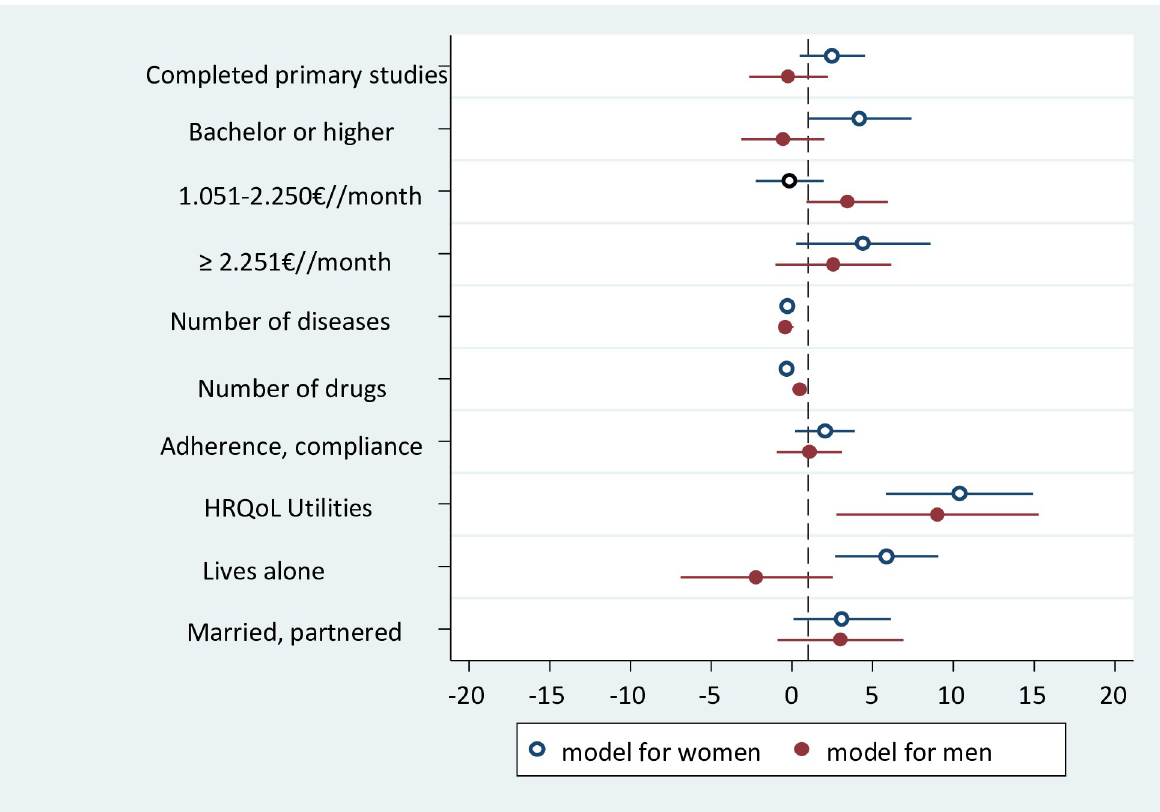
Fig 1. Differences by sex found in the final